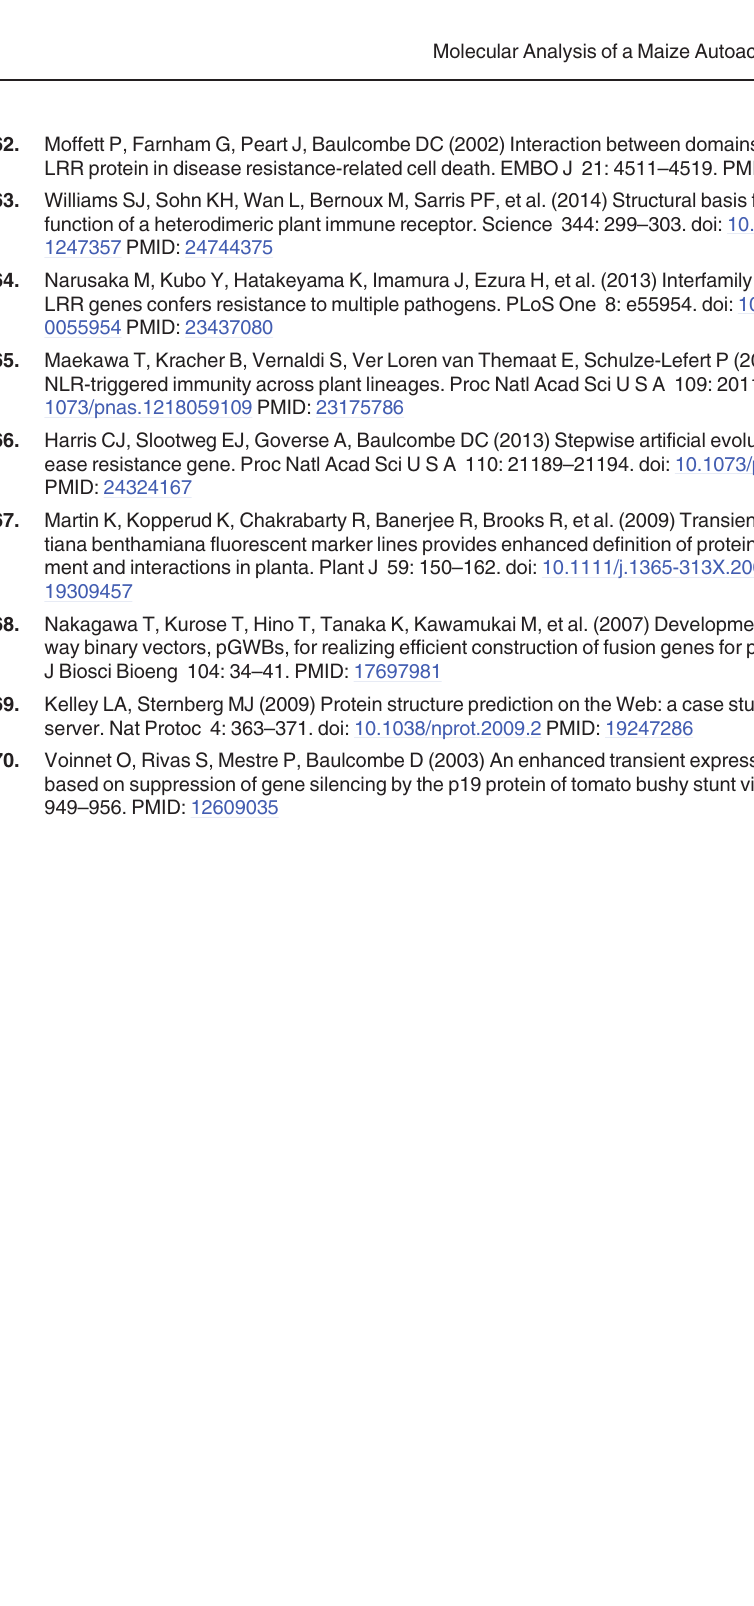
PLOS Pathogens | DOI:10.1371/journal.ppat.1004674 February 26,